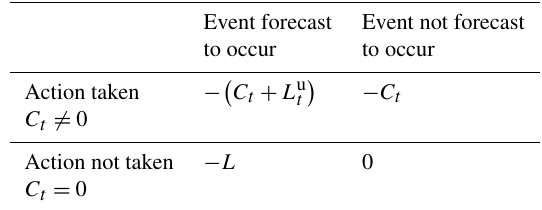
Table A1. Ex ante utility values for a time step of expected utility theory with REV assumptions.